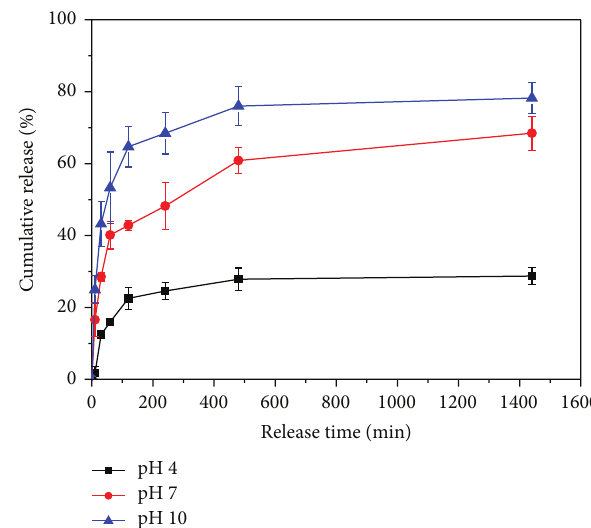
Figure 6: Cumulative release profiles of ibuprofen from chitosan- ibuprofen hydrogels under different pH